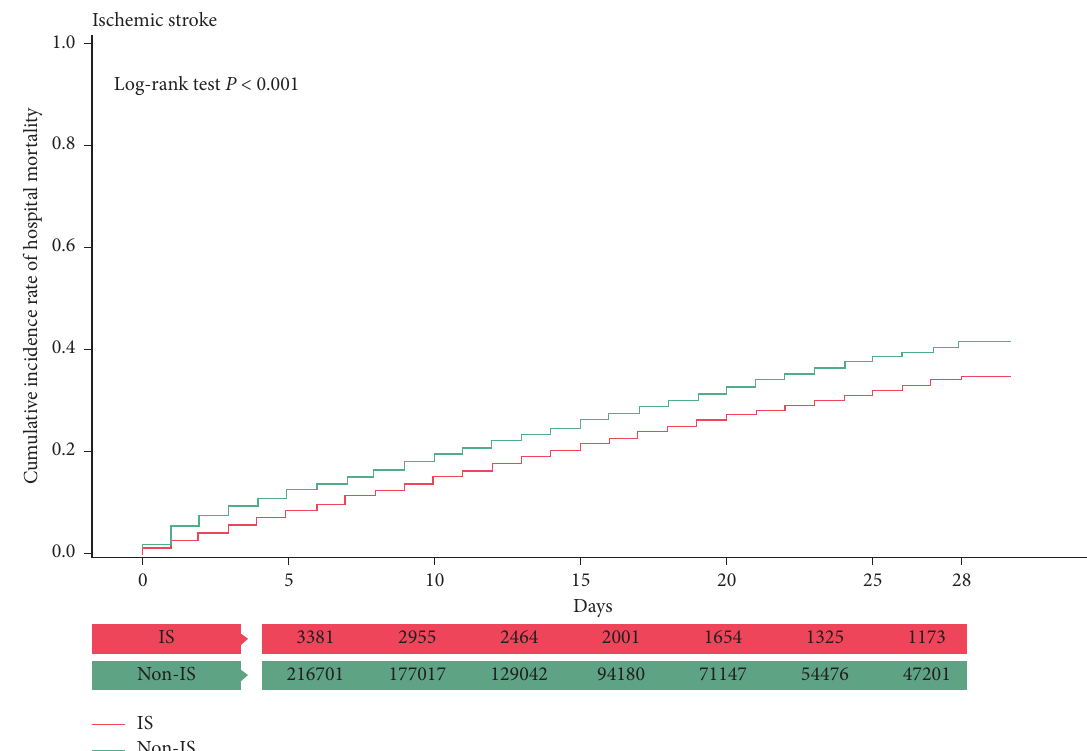
Figure 3: Kaplan–Meier analysis of cumulative hospital mortality in sepsis patients with and without ischemic stroke. The differences were evaluated by the log-rank